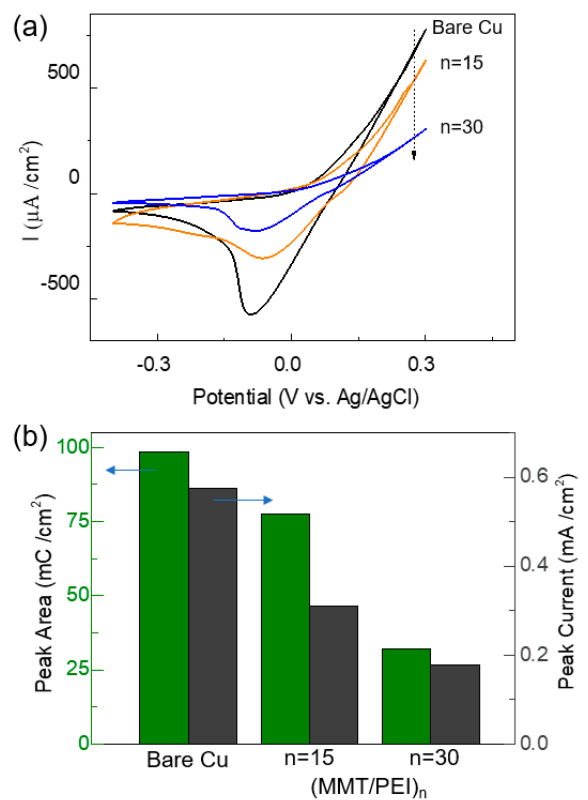
Figure 4. ( a ) Cyclic voltammograms of (MMT-PEI) n -coated copper electrodes in 5 mM NaCl solution. pH 4 MMT solution was used for assembling LbL-(MMT-PEI) n. CVs at the 5th cycle. ( b ) Current peak value and total charge of cathodic peak calculated from CVs in Figure 4. ( a ). Scan rate = 10 mV /